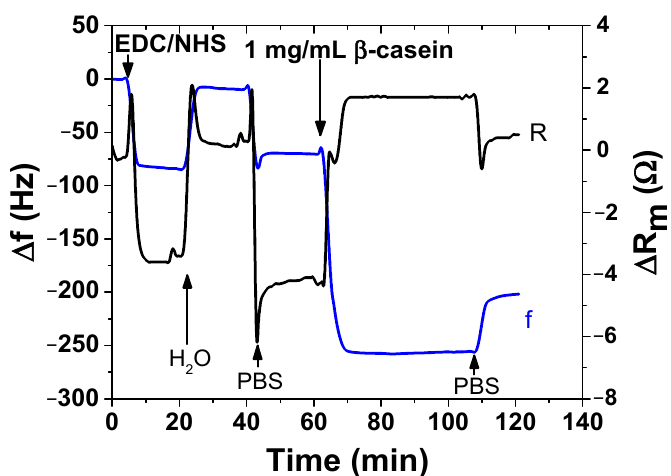
Figure 9. Kinetics of resonant frequency, f (blue), and motional resistance, R m (black), changes during modification of piezocrystal by β -casein. The carboxylic groups of MUA that were chemisorbed at the crystal were first activated by EDC/NHS. The moments of addition of various compounds as well as washing the surface by water and PBS are shown by arrows.